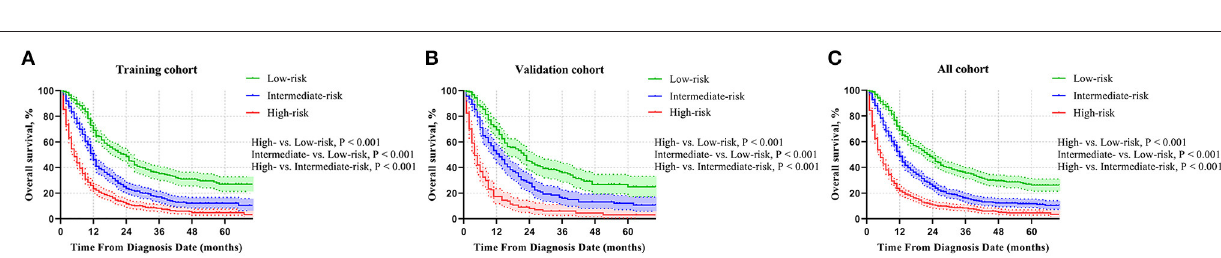
tumor or metastatic sites) was also observed to significantly correlate with better OS ( P = 0.012, HR = 0.40) and PFS ( P = 0.027, HR = 0.42), respectively